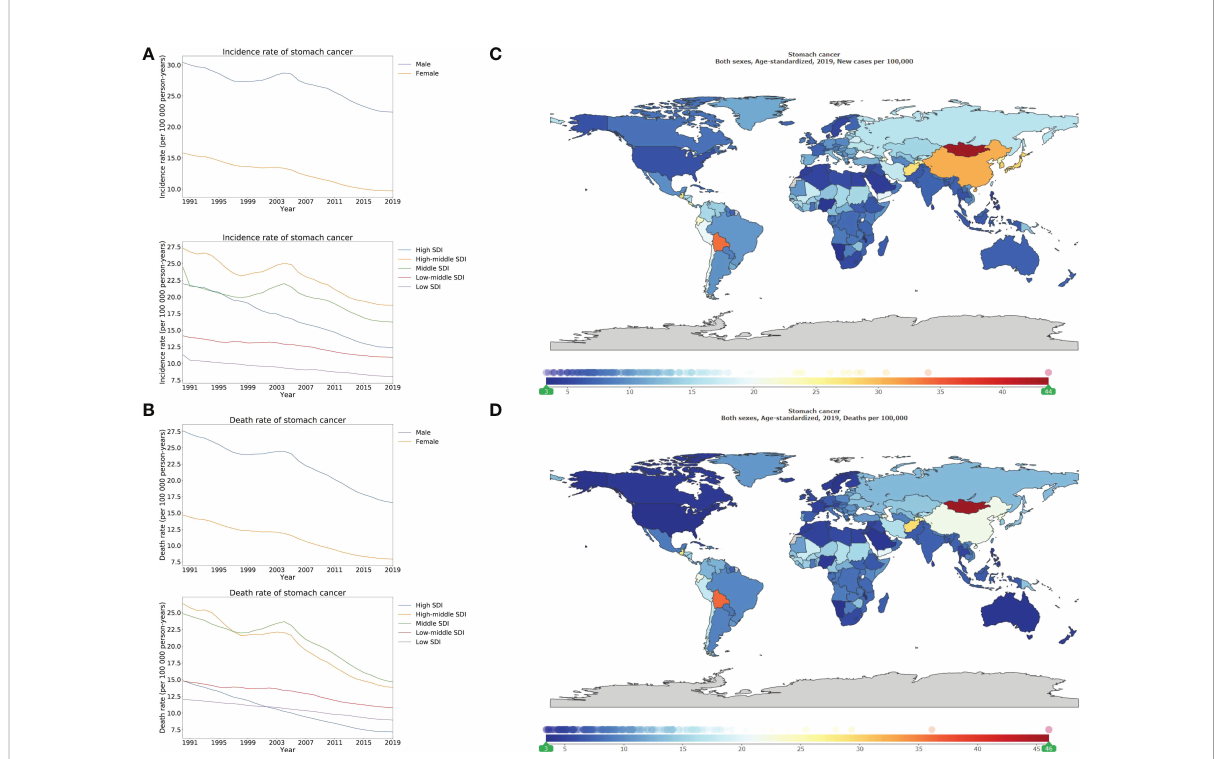
FIGURE 3 Burden of stomach cancer for 204 countries and territories. Age-standardized incidence (A) and death (B) rate per 100000 population of stomach cancer from 1990 through 2019 by country and territory, strati fi ed by sex or SDI; age-standardized incidence (C) and death (D) rate of stomach cancer per 100000 person-years by country and territory, in 2019. The maps in (C) and (D) were generated by GBD 2019